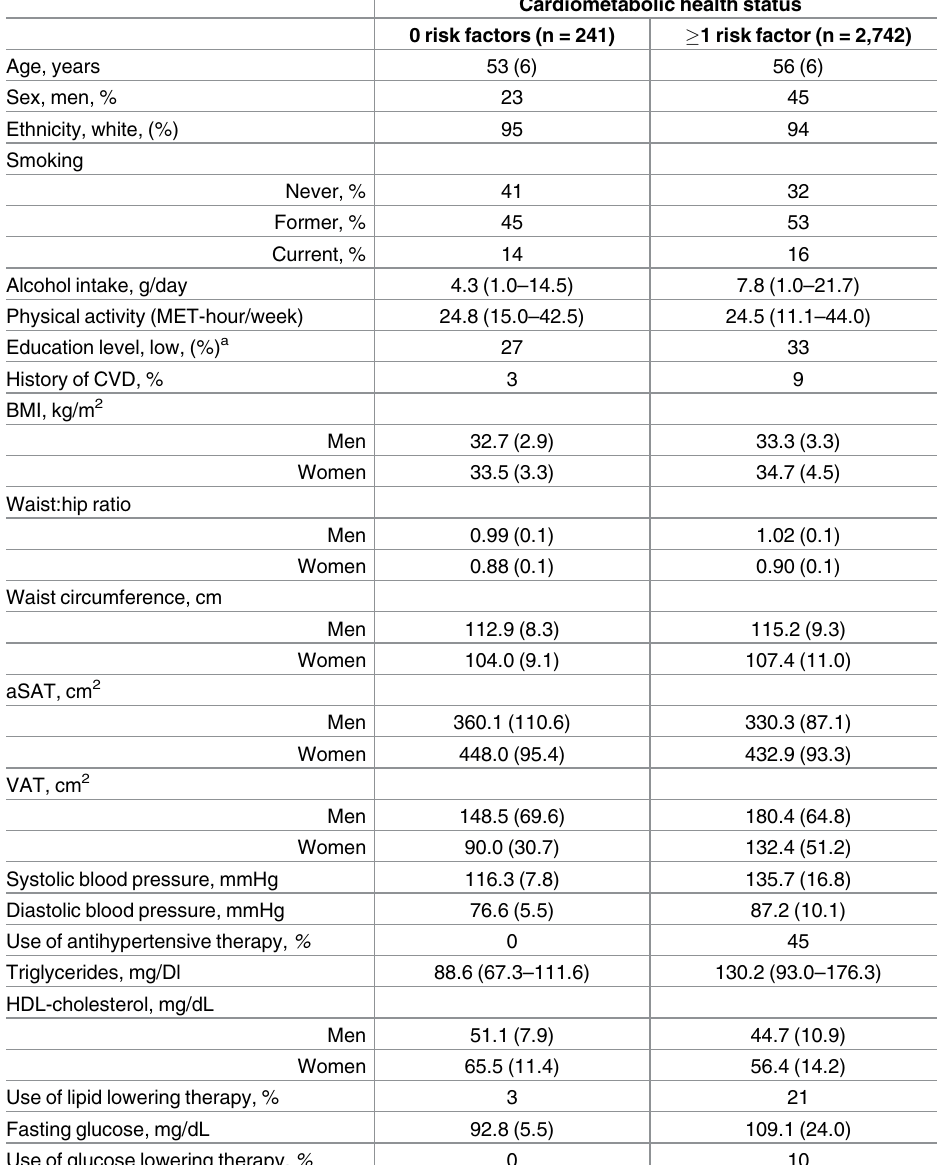
Cardiometabolic health status